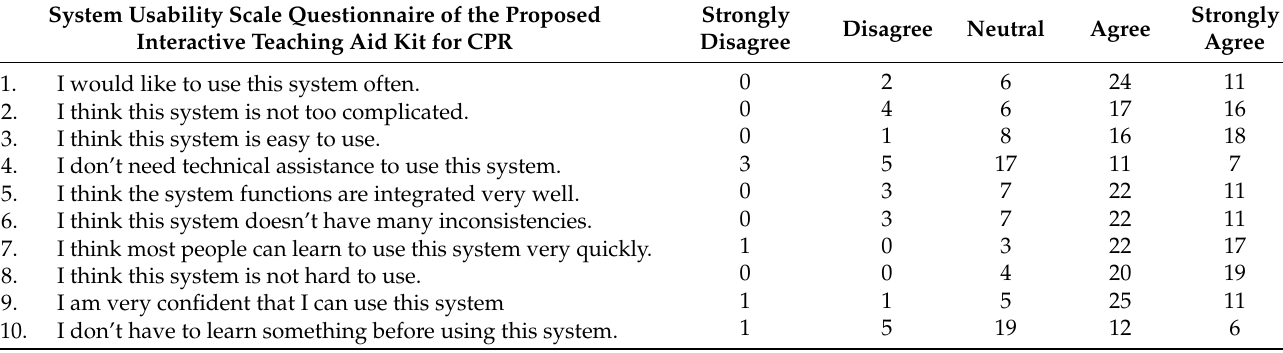
Table 2. The results of the questionnaire.